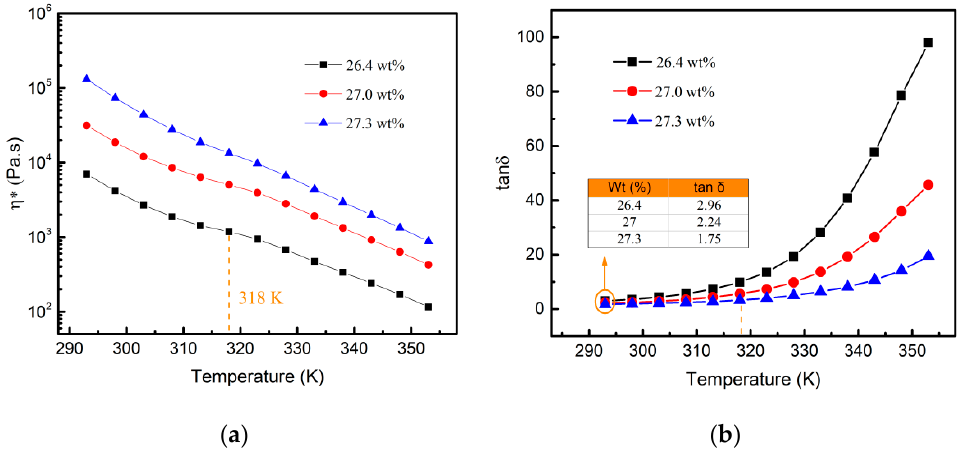
Figure 6. The dynamic rheological behavior of the aluminum sols at different temperatures: ( a ) com- plex viscosity; ( b ) tan δ .